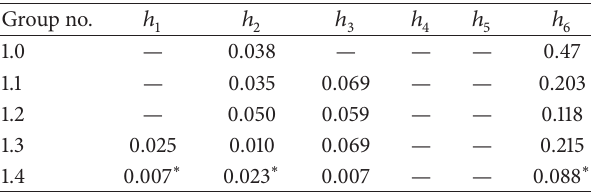
Table 3: Standard deviations of the levels for